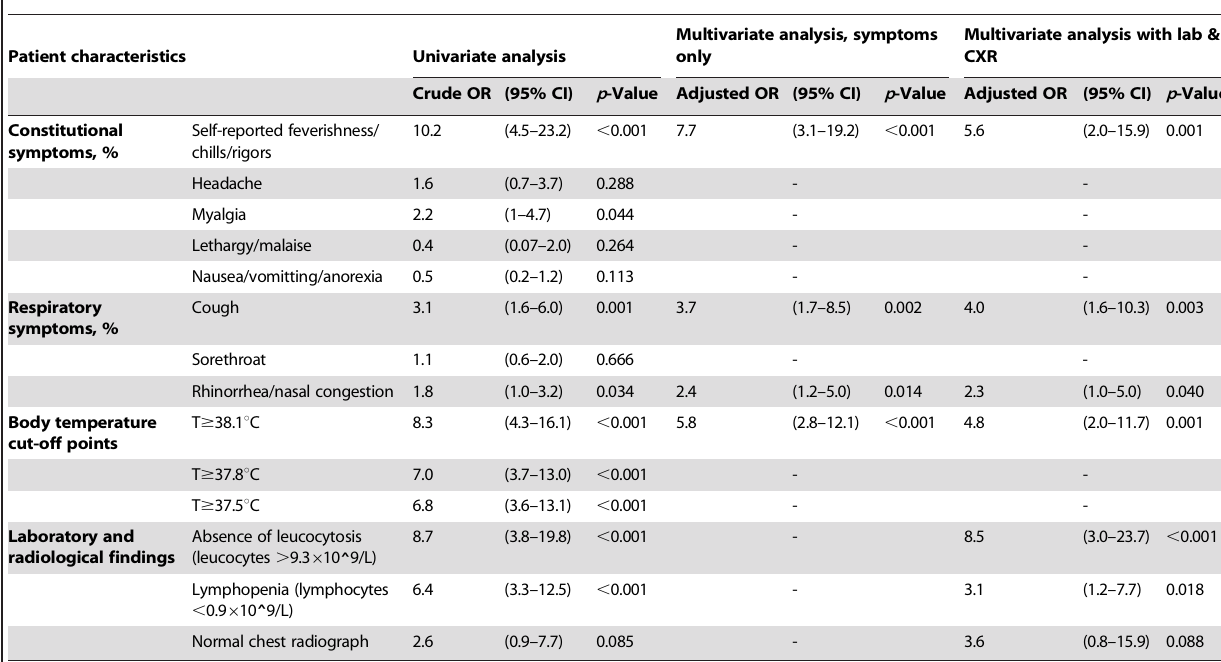
Table 4. Univariate and multivariate analyses comparing seasonal influenza and ARI patients.